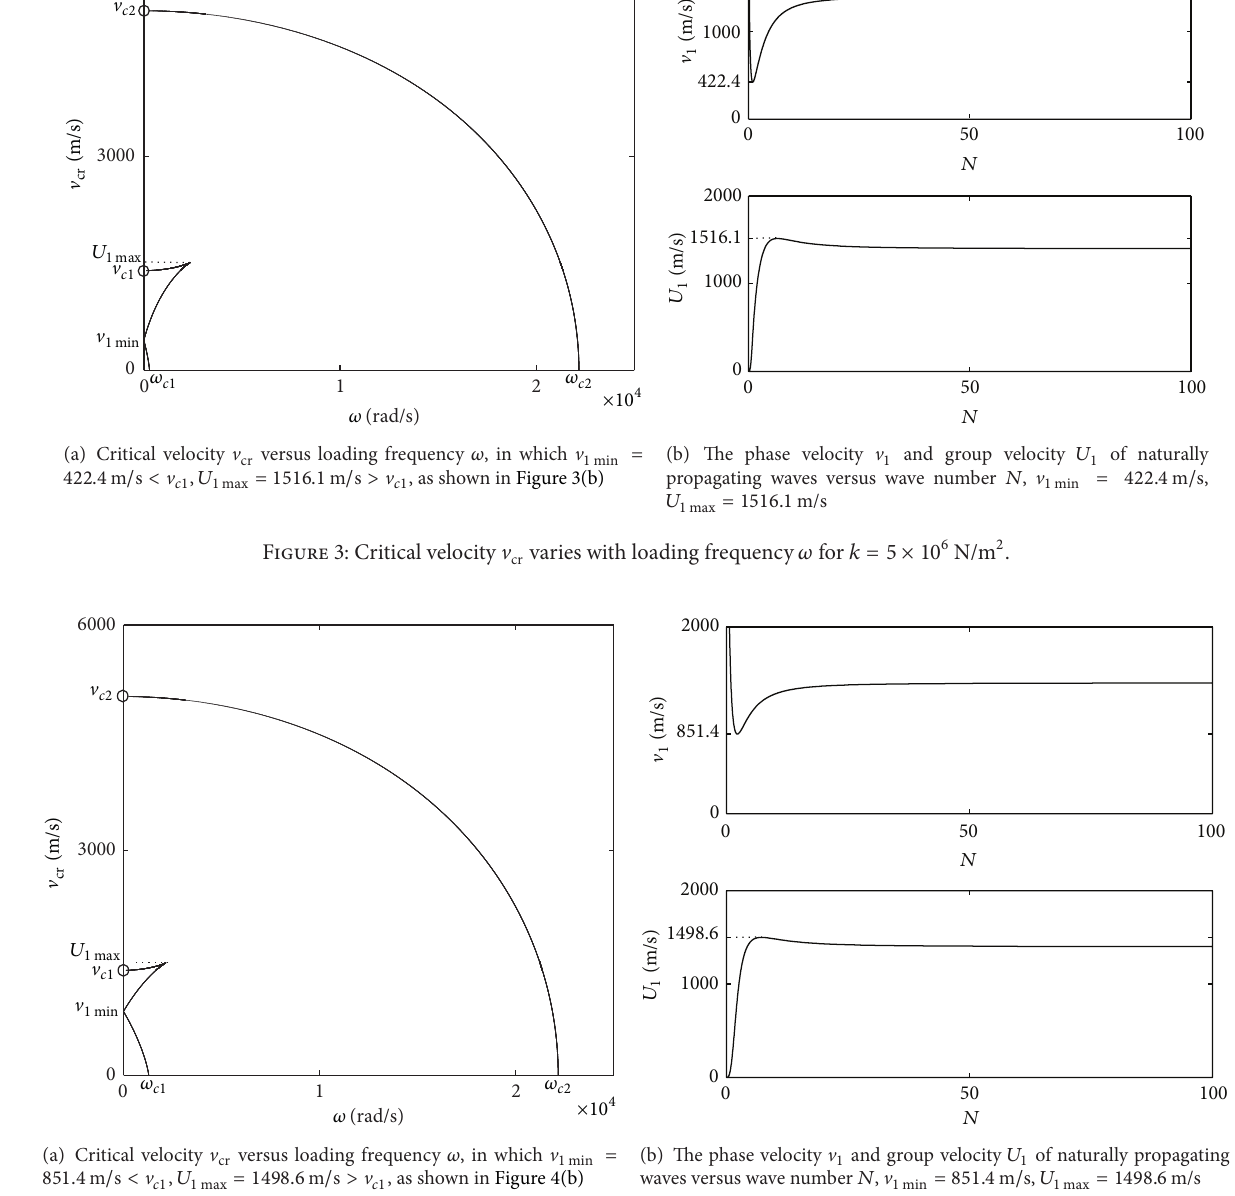
Figure 4: Critical velocity V